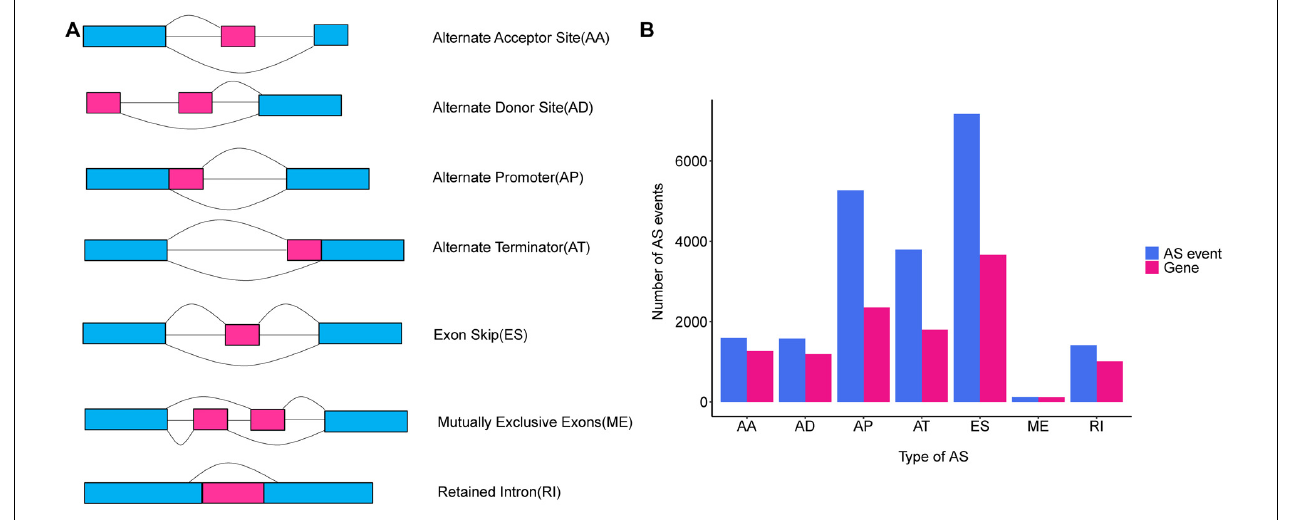
FIGURE 1 | An overview of seven classical subgroups of alternative splicing (AS) patterns. (A) Schematic illustration splicing pattern of seven subgroups of AS events. AA, alternate acceptor site; AD, alternate donor site; AP, alternate promoter; AT, alternate terminator; ES, exon skip; ME, mutually exclusive exons; RI, retained intron. (B) The number of AS events (blue bars) and genes in parents (red bars) among the seven subgroups of TNBC taken from analysis of 151 TNBC patients in TCGA SpliceSeq